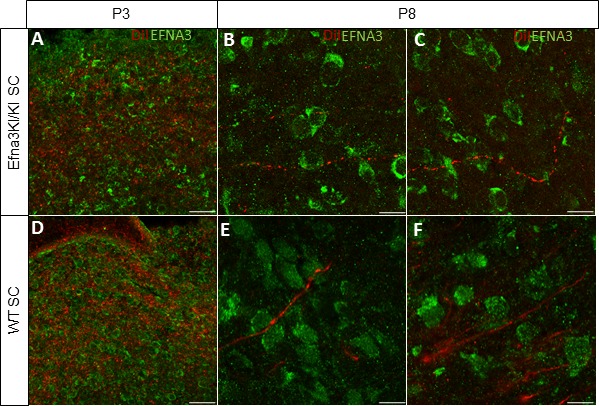
Immunostaining revealing EFNA3 expression (green) in P3 (A, D) and P8 (B–F) Efna3KI/KI and WT SC parasagittal sections after retinal anterograde DiI injection (red fibers).Scale bars represent 30 µm (A, D), 10 μm (B - F).